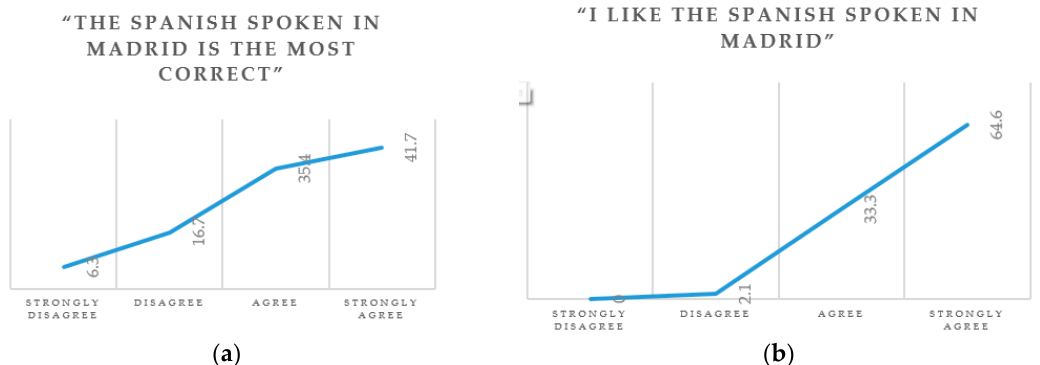
Figure 8. Results from Romanian informants on their attitudes toward the speech of Madrid. ( a ) Results of the item “The Spanish spoken in Madrid is the most correct”. ( b ) Results of the item “I like the Spanish spoken in Madrid”.